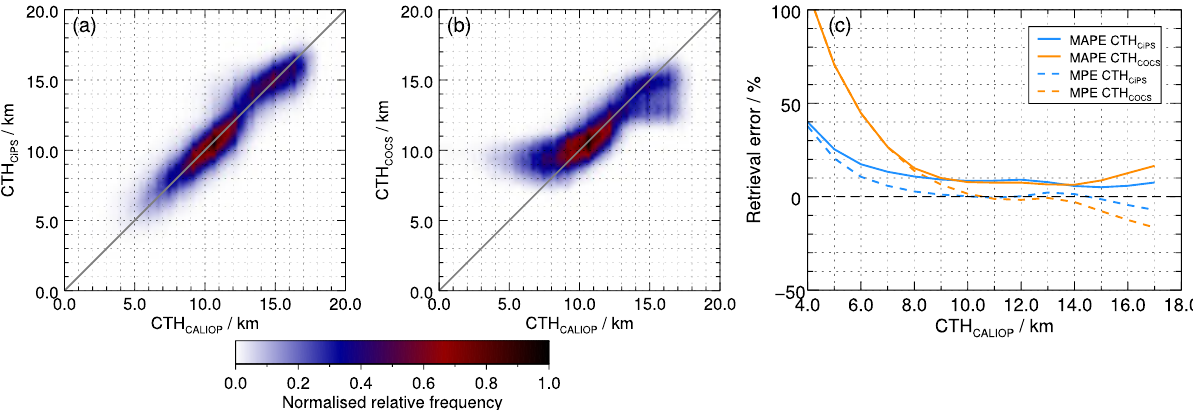
Figure 9. Density scatter plots with the CTH retrieved by (a) CiPS and (b) COCS on the vertical axes and the corresponding V3 CALIOP data on the horizontal axes. The grey lines represent the 1–1 line. (c) The MAPE (solid) and MPE (dash) of the CTH retrieved by CiPS and COCS with respect to the CTH measured by CALIOP.